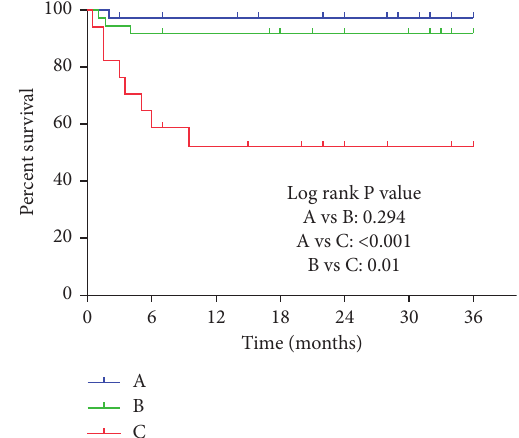
Figure 5: Prediction of subtype clinical outcomes (survival